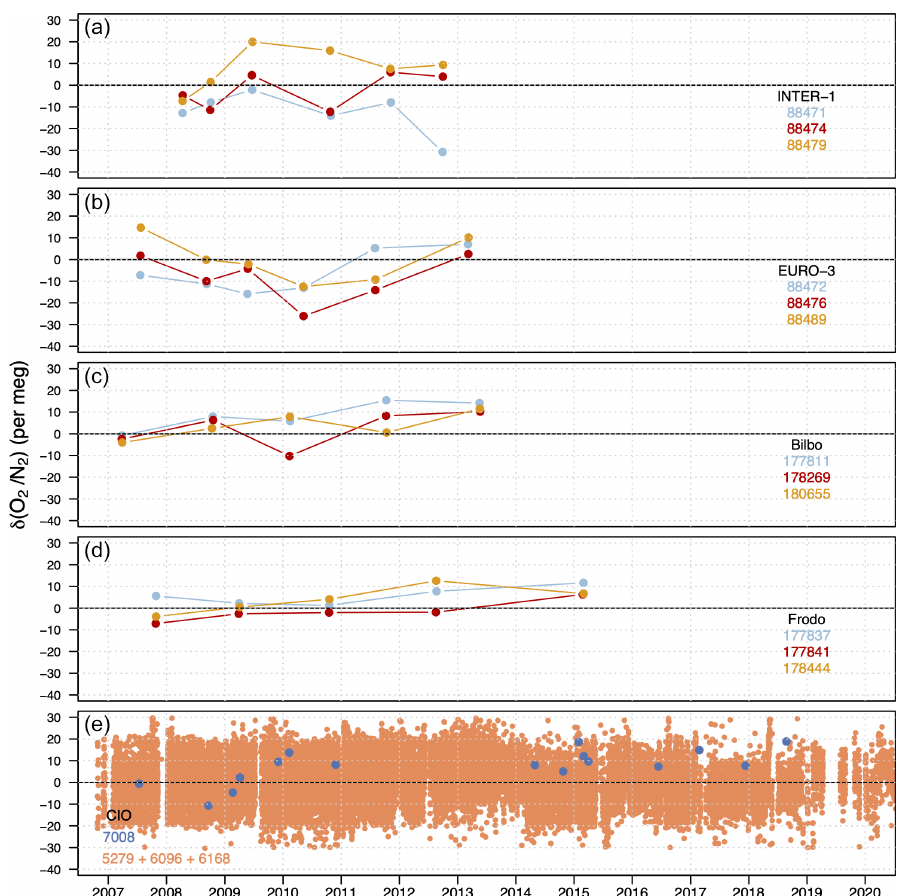
Figure 6. Cylinders from the Cucumber programme (a, b) along with two sets of three cylinders in the GOLLUM programme (c, d) and three internal CIO cylinders (WT 5279, WT 6096, and WT 6168) and a primary standard cylinder at CIO (SIO 7008) (e) . Each colour represents a different cylinder, and the legends show the corresponding cylinder IDs. The points are the measurements of the cylinders over time, plotted as the difference from their assigned values. For the Cucumber, GOLLUM, and SIO cylinders, the assigned values are determined at the SIO, and for the WTs, the assigned value is its long-term average measured at CIO on the SIO scale. y axis ranges are identical for all